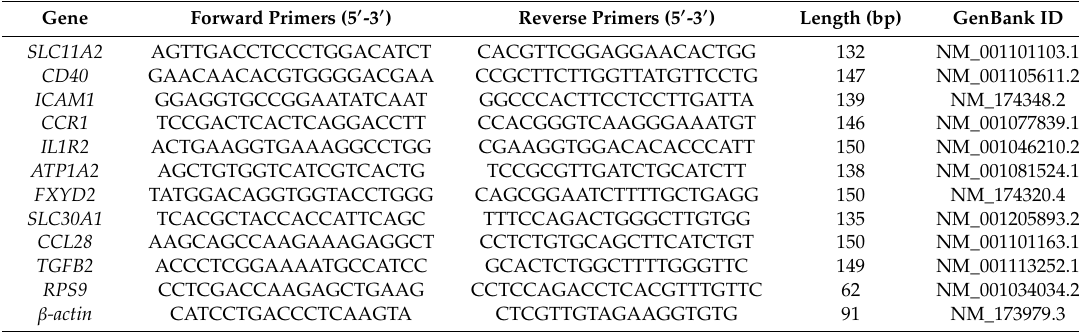
Table 1. Primers used in quantitative real-time